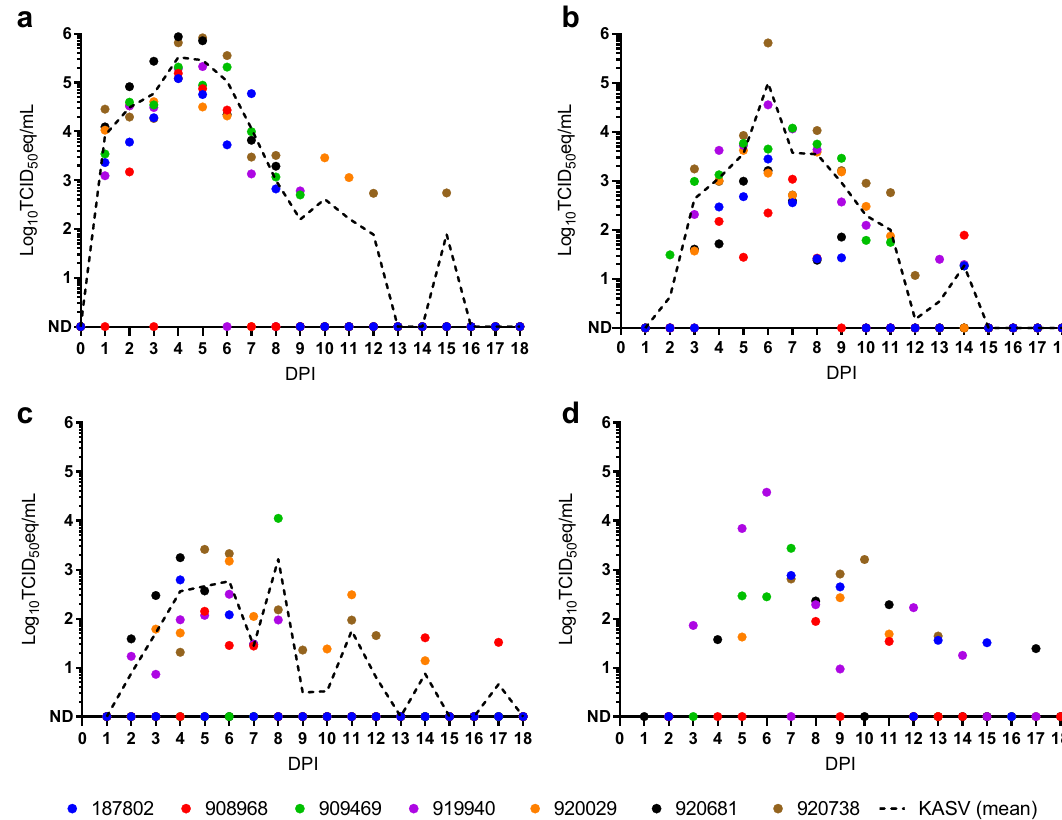
Figure 2. Kasokero virus (KASV) loads in specimens obtained from serially-sampled, KASV-inoculated bats. KASV loads (qRT-PCR-derived log 10 TCID 50 eq/mL) in ( a ) blood, ( b ) oral swabs, ( c ) rectal swabs, and ( d ) urine obtained from 0 to 18 days post inoculation (DPI). The dotted lines in panels a–c represent overall mean viral loads. The overall mean viral load for urine is not depicted in panel d, as this sample type was collected opportunistically, thereby biasing any measure of central tendency. ND: Not